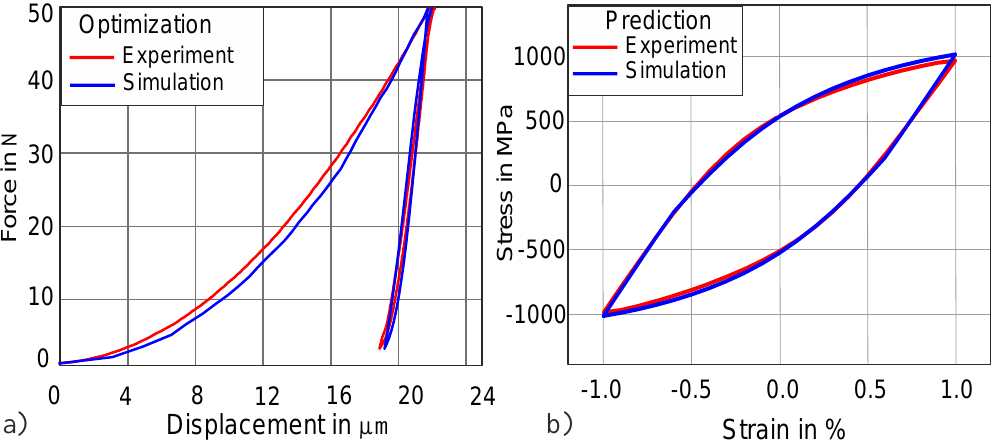
Figure 6. ( a ) Complete cycle of the force – displacement curve from indentation, with normalized mean square error (NMSE) = 2.0 × 10 −5 . ( b ) Predicted uniaxial stress – strain hysteresis with a plastic work error of 2.5%.